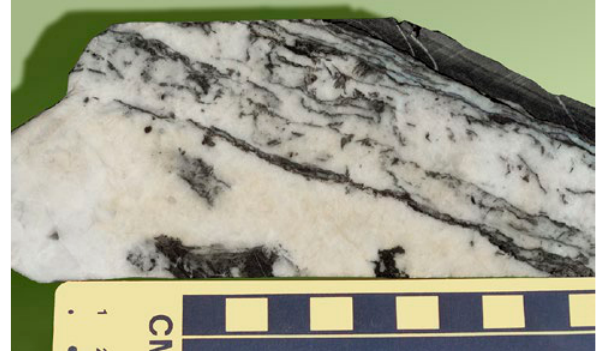
Figure 42. Several successive ‘layers’ of additional quartz have been injected at the precursor stage beside the first of these quartz veins in the Wagga Tank prospect drill core. Chlorite septa on their mar- gins separate the different additional intrusions but this has largely been disrupted by influx of polymeric silica. This has dispersed and disoriented pieces of the chloritic vein walls through the later intruded silica. Small chlorite ‘needles’ have crystallised in the soft polymeric silica before it finally also crystallised.